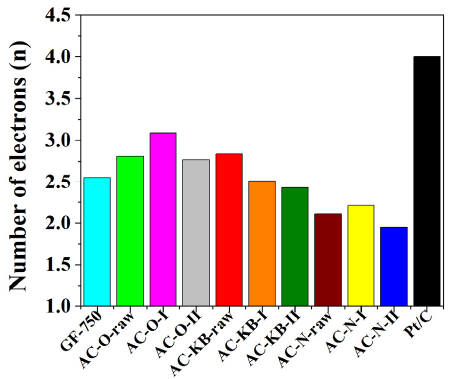
Figure 10. The number of transfer electrons in ORR for all samples compared with commercial Pt/C and commercial graphene nanoplatelets